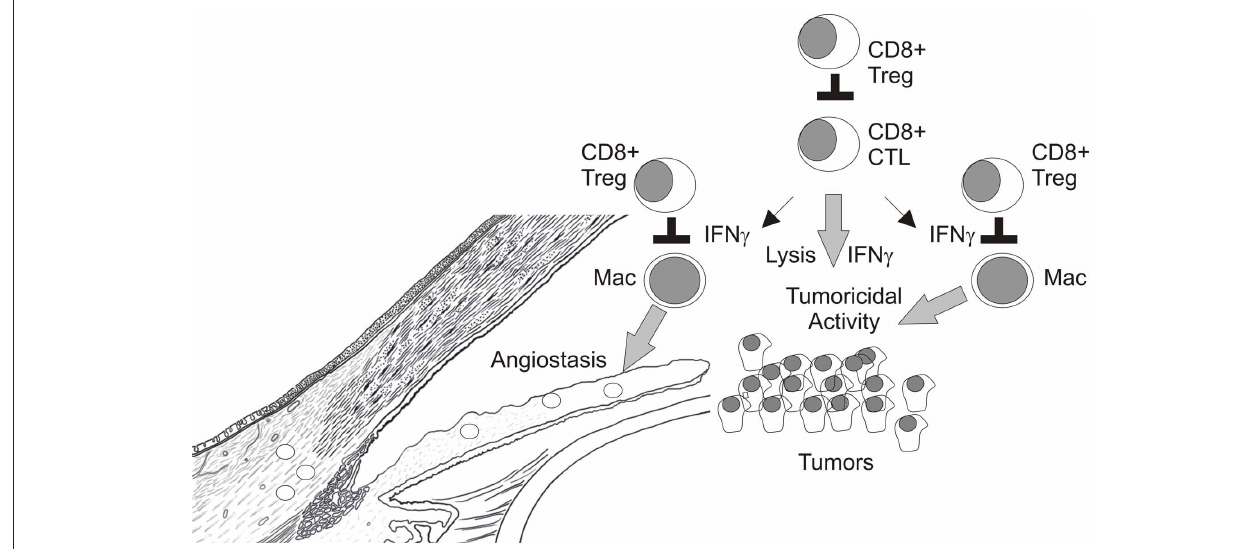
FIGURE 6 | Potential targets of CD8 + Treg in intraocular